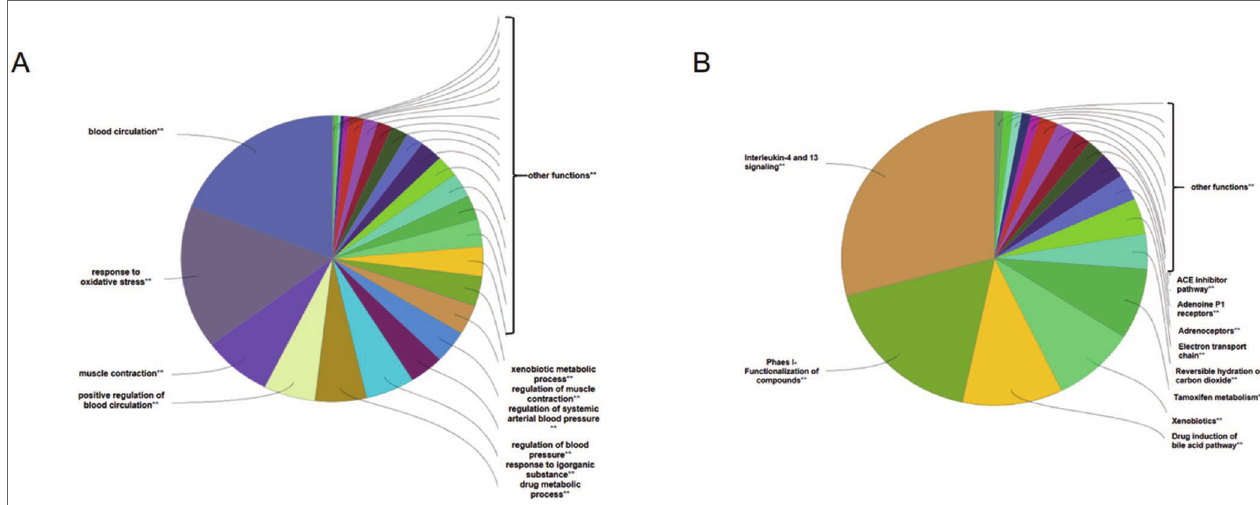
FIGURE 4 | ClueGO analysis of the candidate targets. (A) Representative biological process among 120 candidate targets. (B) Representative reactome and Wiki pathway analysis amng 120 candidate targets. Only top ten concerned biological processes and pathways were shown in figures.